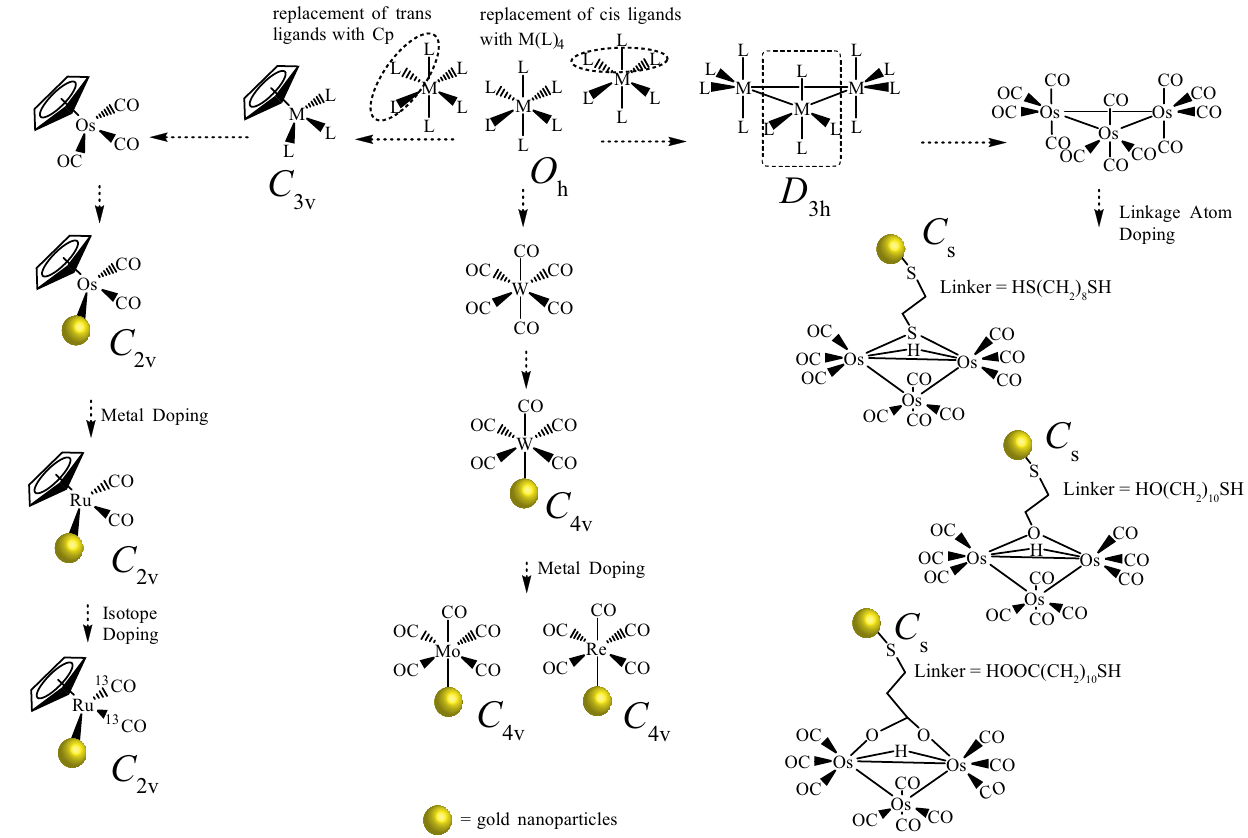
Fig. 1 Geometrically encoded SERS nanobarcodes. Engineering of SERS nanoparticles via geometric control of metal carbonyl